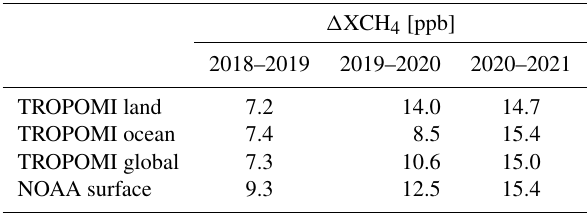
Table 1. Atmospheric XCH 4 growth rate calculated as the differ- ence between annual mean column-averaged methane measured by TROPOMI over land, over ocean and globally (land and ocean) and surface methane measured by NOAA marine ground-based